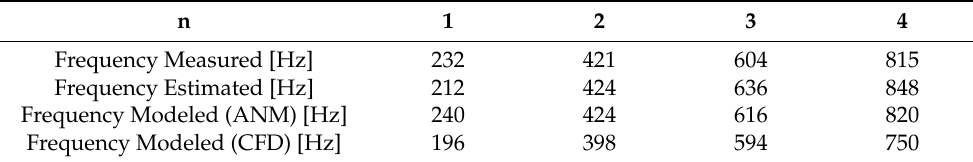
Figure 8. Comparison of measured and predicted pressure spectra in the combustion chamber. Table 2. Acoustic